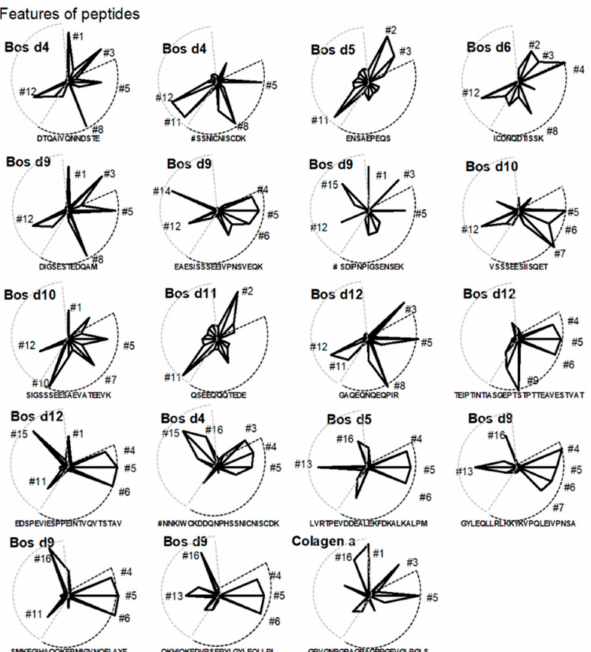
Figure 2. Dominant peptides features integrated with the strength of individual feature in the form of a radial